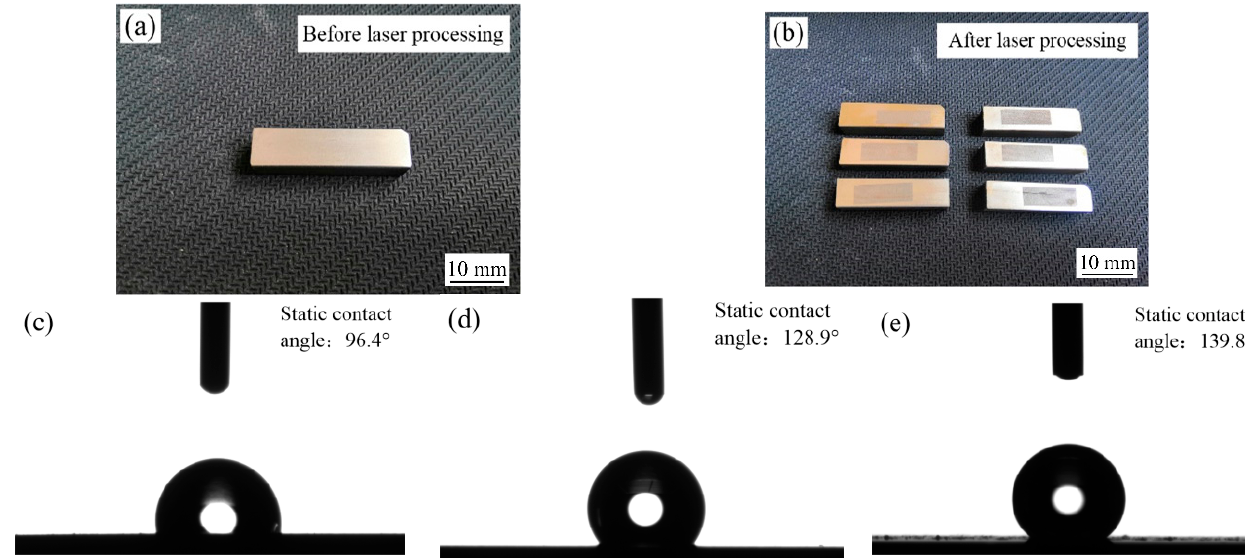
Figure 18. Images and water contact angle of samples before and after laser processing: ( a ) image before laser processing; ( b ) image after laser processing; ( c ) water contact angle of steel C1045 substrates; ( d ) water contact angle of samples before laser processing; ( e ) water contact angle of samples after laser processing.